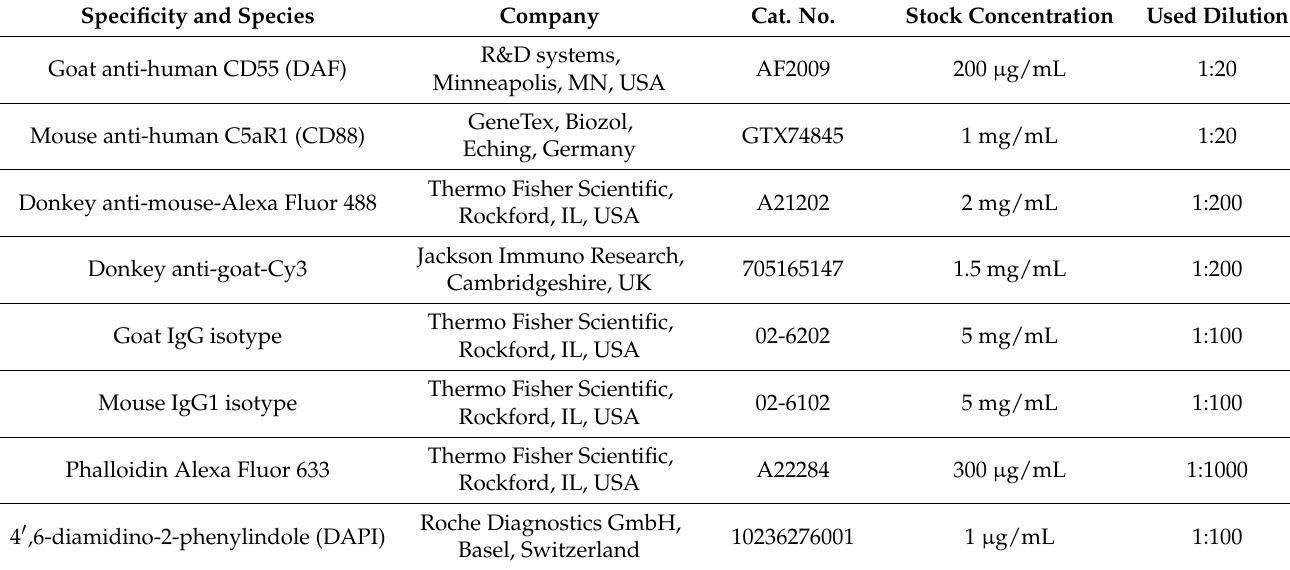
Table 2. Antibodies and dyes